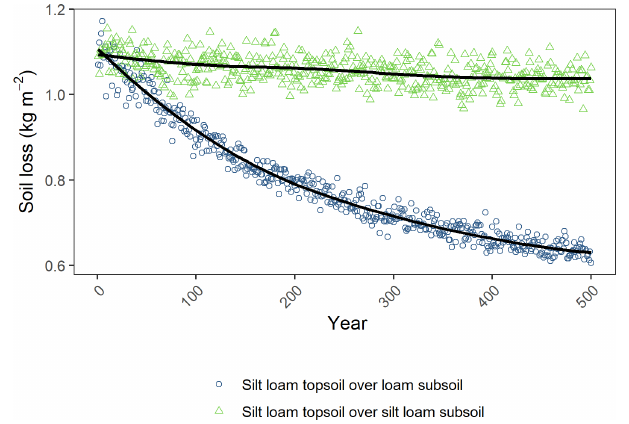
Figure 6. Soil erosion trends over 500 years of model simula- tions for two representative profiles from the UK SOILPITS dataset. Coloured symbols are the median of the simulations per year, and the solid lines are local regression functions adjusted from the